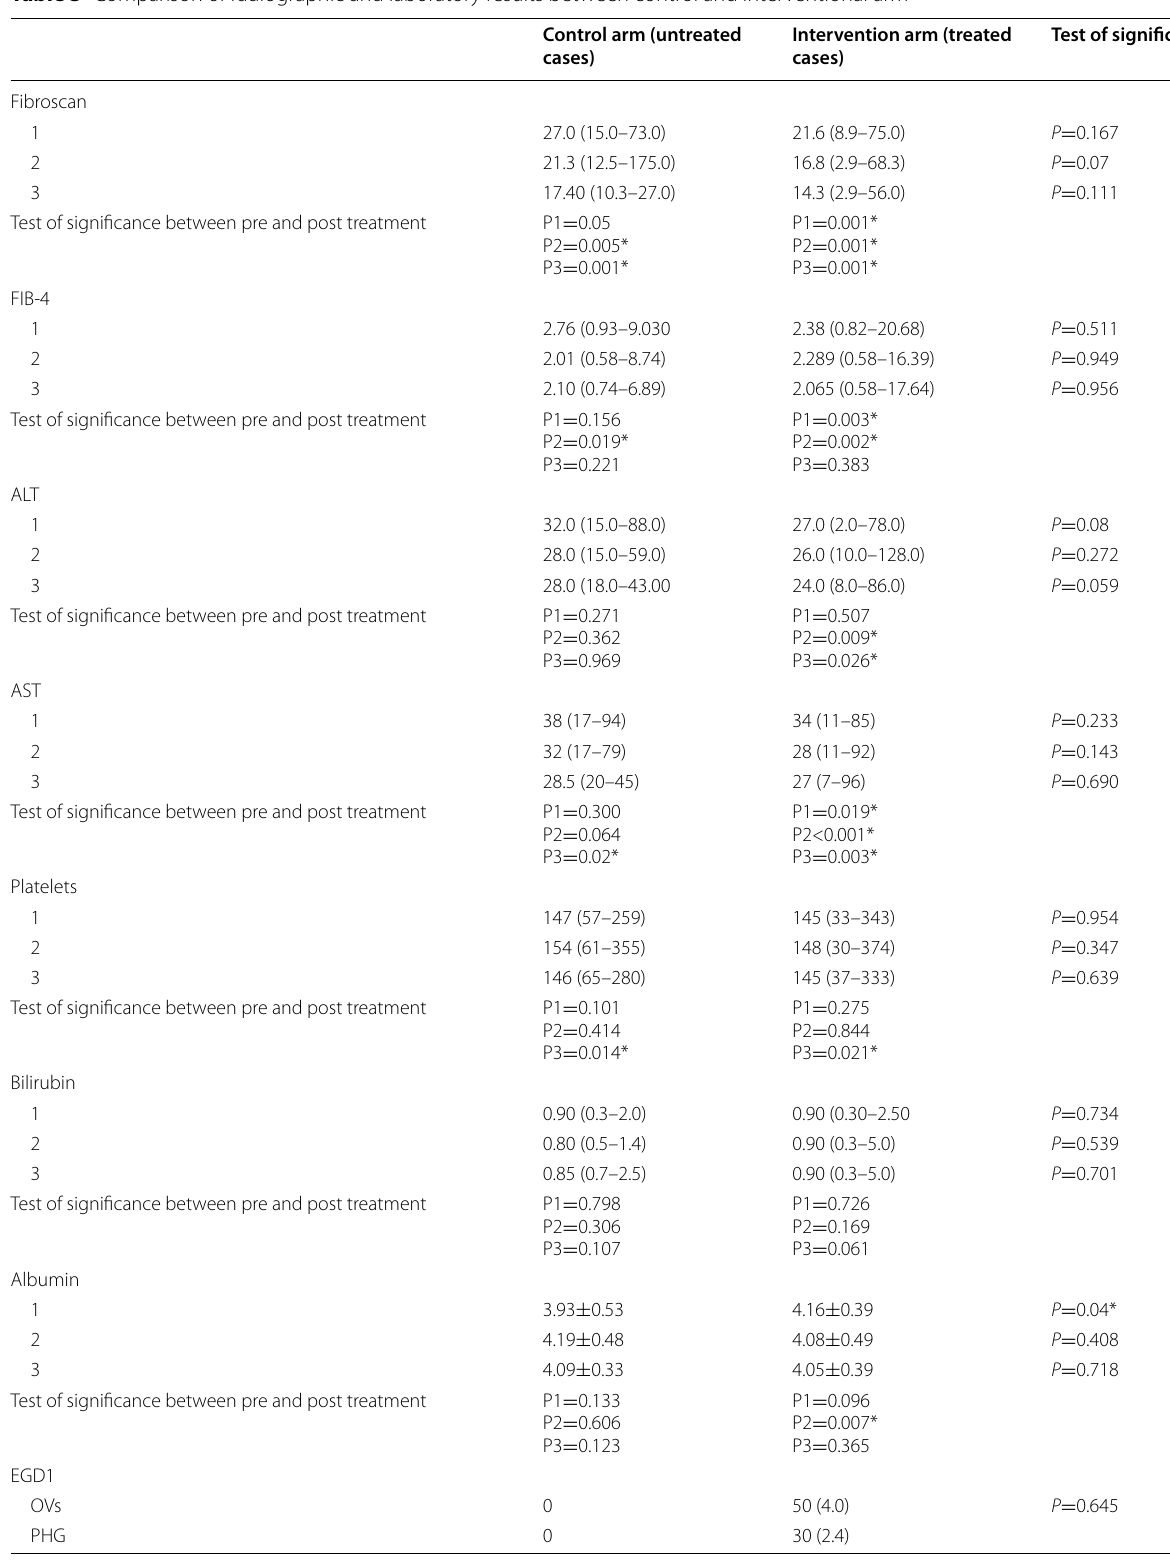
Table 3 Comparison of radiographic and laboratory results between control and interventional arm